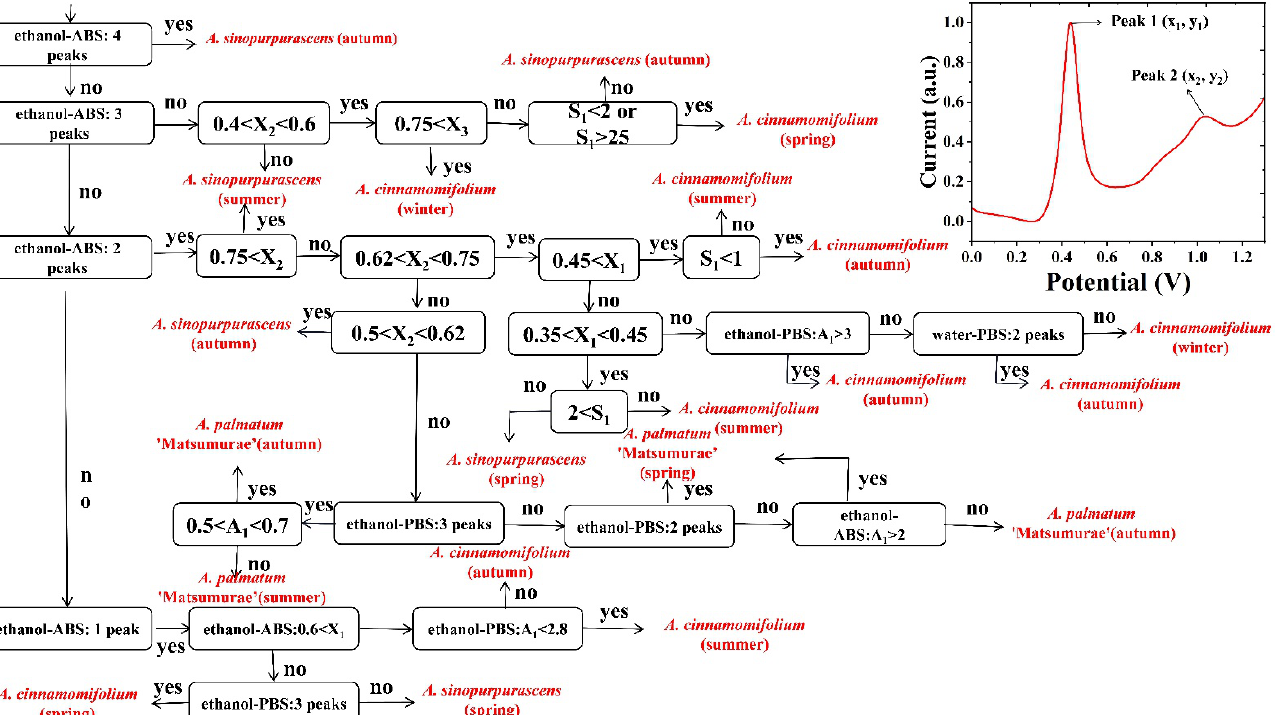
Figure 7. Confusion matrix of proposed flow chart.